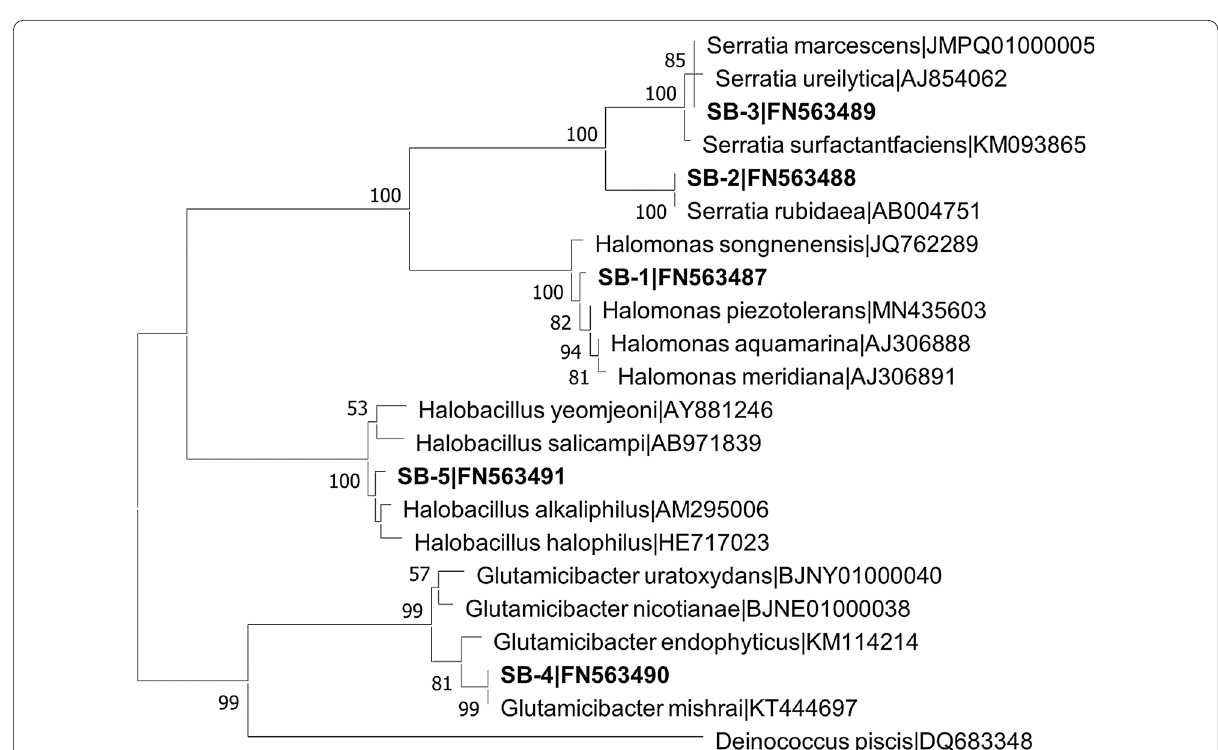
Fig. 2 16S rRNA gene sequence-based neighbor-joining phylogenetic tree, showing the position of halotolerant phosphate solubilizing strains isolated from saline soil among members of the related genera. Bar, 0.05 substitutions per nucleotide